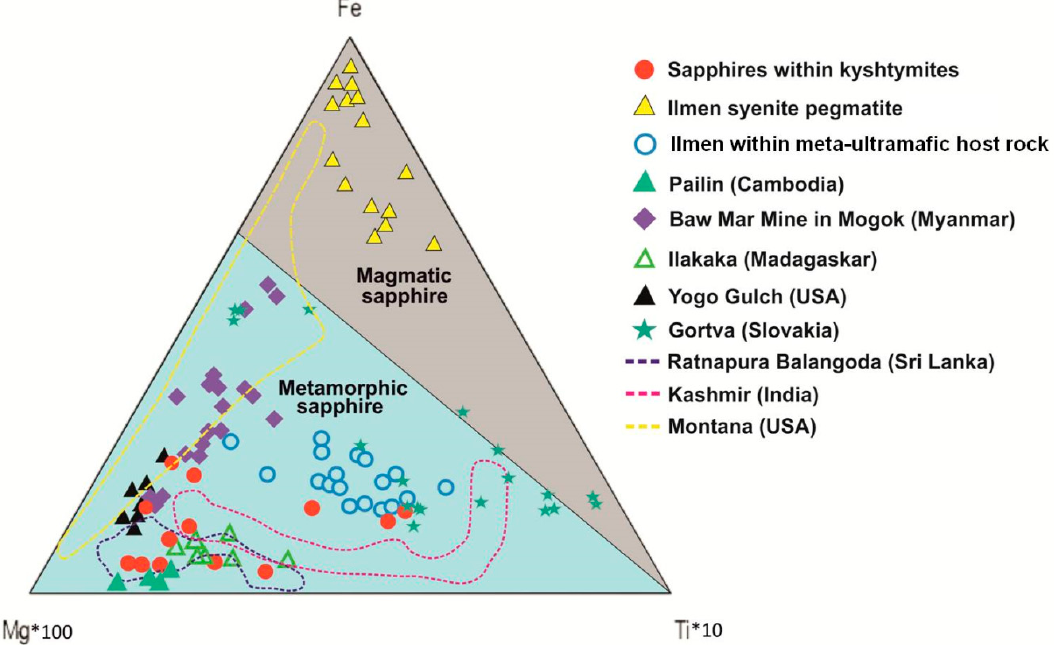
Figure 7. A Fe–Mg*100–Ti*10 ternary plot modified after Peucat et al. (2007) [35] of corundum-sapphire within kyshtymites, Ilmen sapphires within syenite pegmatites [2], Ilmen sapphires within the meta-ultramafic host rocks [3], and sapphire deposits from other regions after [35]: Pailin (Cambodia), Baw Mar Mine in Mogok (Myanmar), Ilakaka (Madaskar), Ratnapura and Balangoda (Sri lanka), Kasmir (India), and Yogo Gulch (USA). The plot of Gortva sapphire (Slovakia) is after Uher et al. (2012) [38] and Montana (USA) sapphires are after Zwaan et al. (2015) [37].